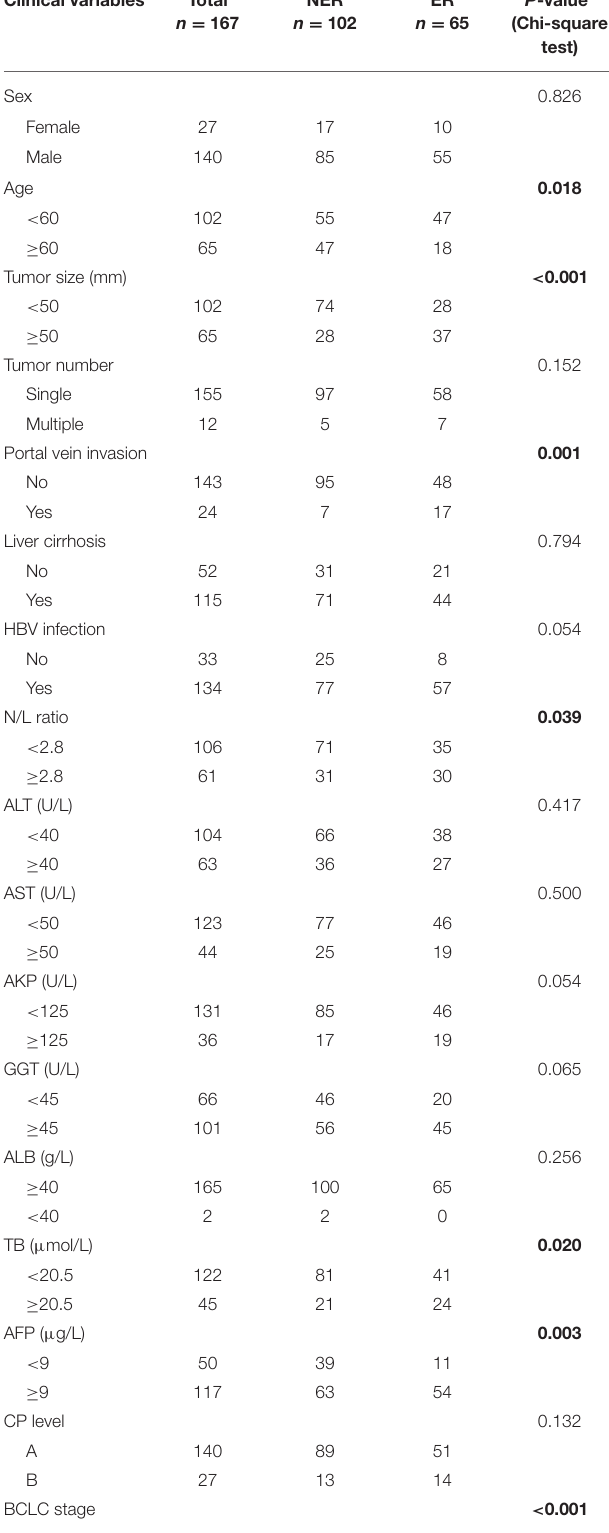
TABLE 1 | Clinical variables of patients with ER and